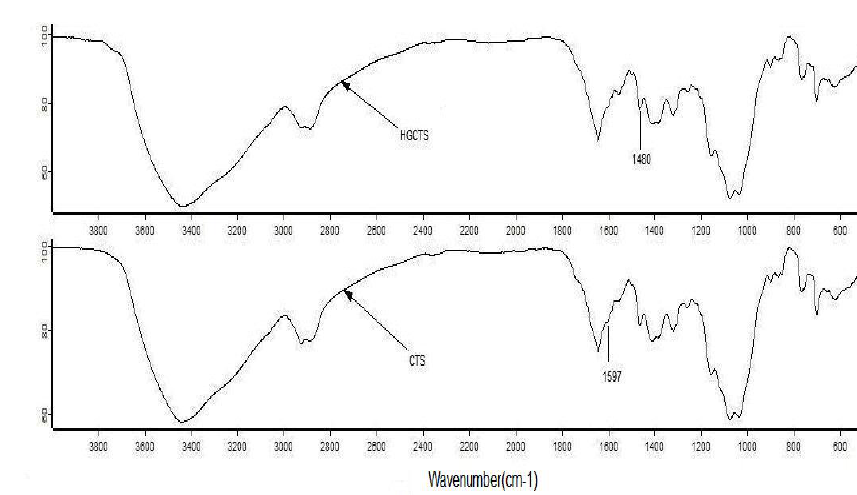
Figure 1. IR spectra of CTS and HGCTS.